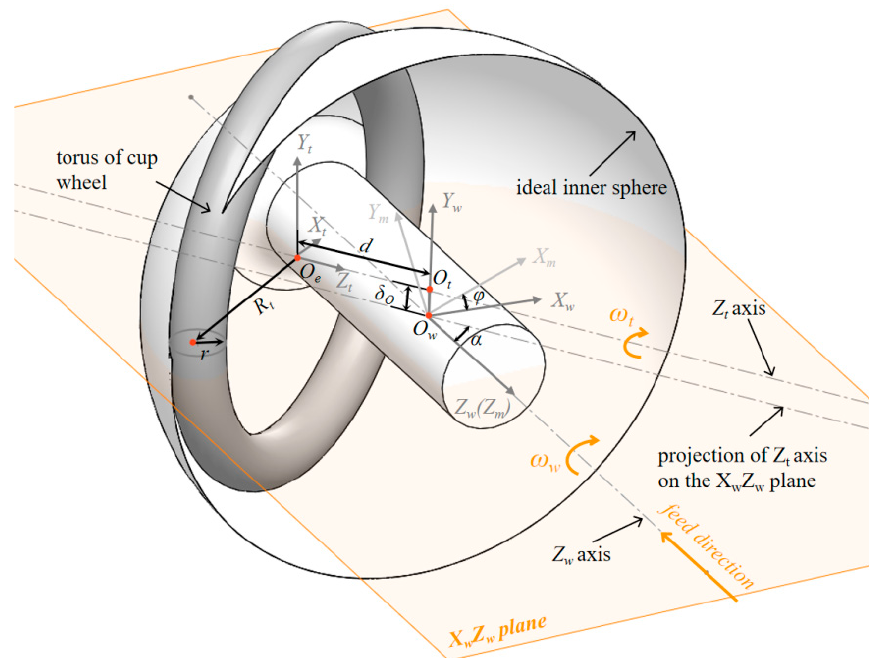
Figure 5. Geometrical model for HSR grinding in the presence of tool setting errors. The machining experiment was conducted on an XZCB four-axis ultra-precision machine tool, as shown in Figure 6. The radial rotation accuracy of the workpiece spindle was less than 0.015 µ m, the radial rotation accuracy of the grinding spindle was less than 1 µ m, and the B-axis resolution was used to control the α angle of the grinding axis to be less than 0.005 arcseconds. The positioning resolution of the grinding spindle along the X-and Z-axis was less than 1 nm. Under this condition, we can ignore the error of the machine tool body and the rotation error of the wheel spindle. The main error sources are as follows: (1) the radius error of the grinding wheel, namely, the radius error of the wheel torus δ r and the pitch radius error δ Rt ; and (2) the four-term tool pose and positional errors of the grinding wheel ( δ o , δ α , δ d , δ z ), as shown in Figure 5, where the vertical distance error δ O is caused by the non-intersection of the grinding wheel spindle Z t and the workpiece spindle Z w , the angle error δ α of the two axes, the distance error δ d between the center point of the grinding wheel torus and O w , and the positional error ensuring the inner and outer sphere concentric δ z of Z m . When the values of the four errors are fixed, the wheel still has the following two degrees of freedom (and does not affect the spherical shape): the rotation of the wheel and the angle ϕ between the workpiece coordinate system and the machine tool coordinate system. When ϕ = 0, the workpiece coordinate system X w Y w Z w and machine tool coordinate system X m Y m Z m coincide. As shown in Figure 3, ϕ represents the revolution angle of the tool spindle around the workpiece spindle, which has the same effect as the workpiece rotation; therefore, the value of ϕ does not affect the machining error of the HSR. Note, the value of ϕ may affect the parallelism between the tool spindle and the X w Z w plane. According to the calculation formula of the angle between the tool spindle Z t axis and the X w Z w plane, the relationship between the two can be obtained as follows: